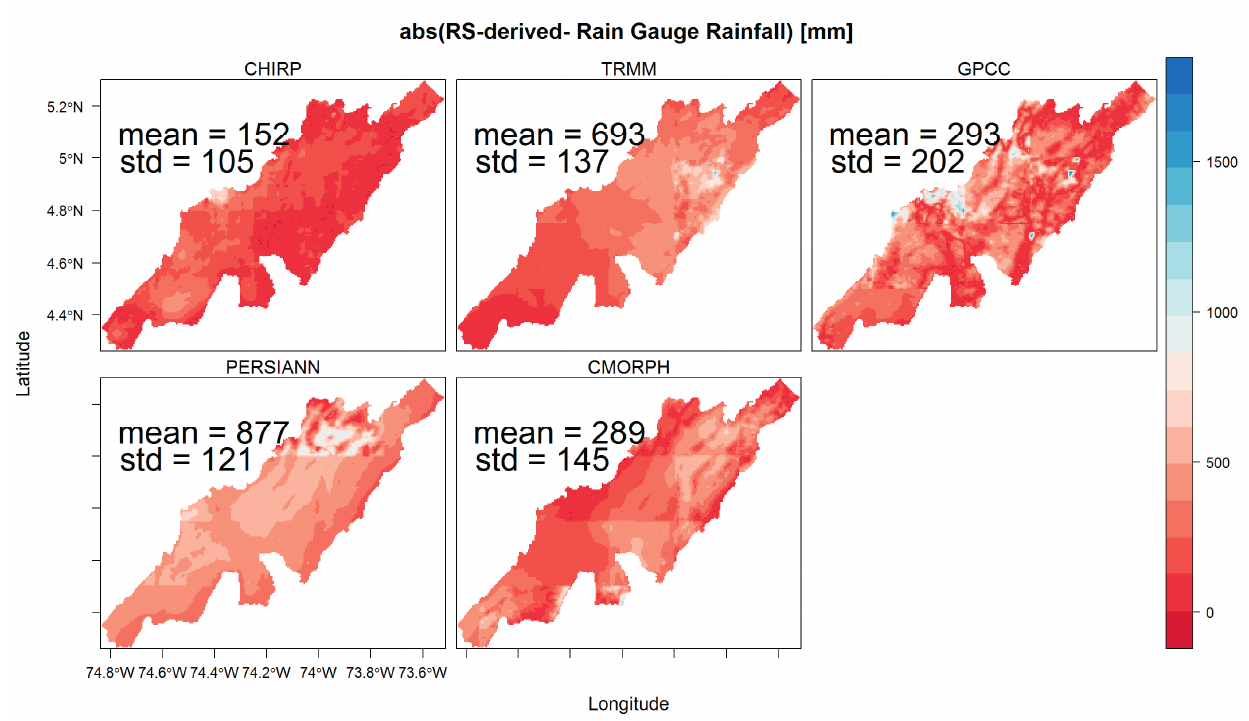
Figure 12. Example of difference between for the Bogotá river Basin in Colombia. Maps represent the absolute value of the difference between RS-derived product and observed rainfall, whereas the text annotations indicate average ( mean ) and standard deviation ( std ) values of the